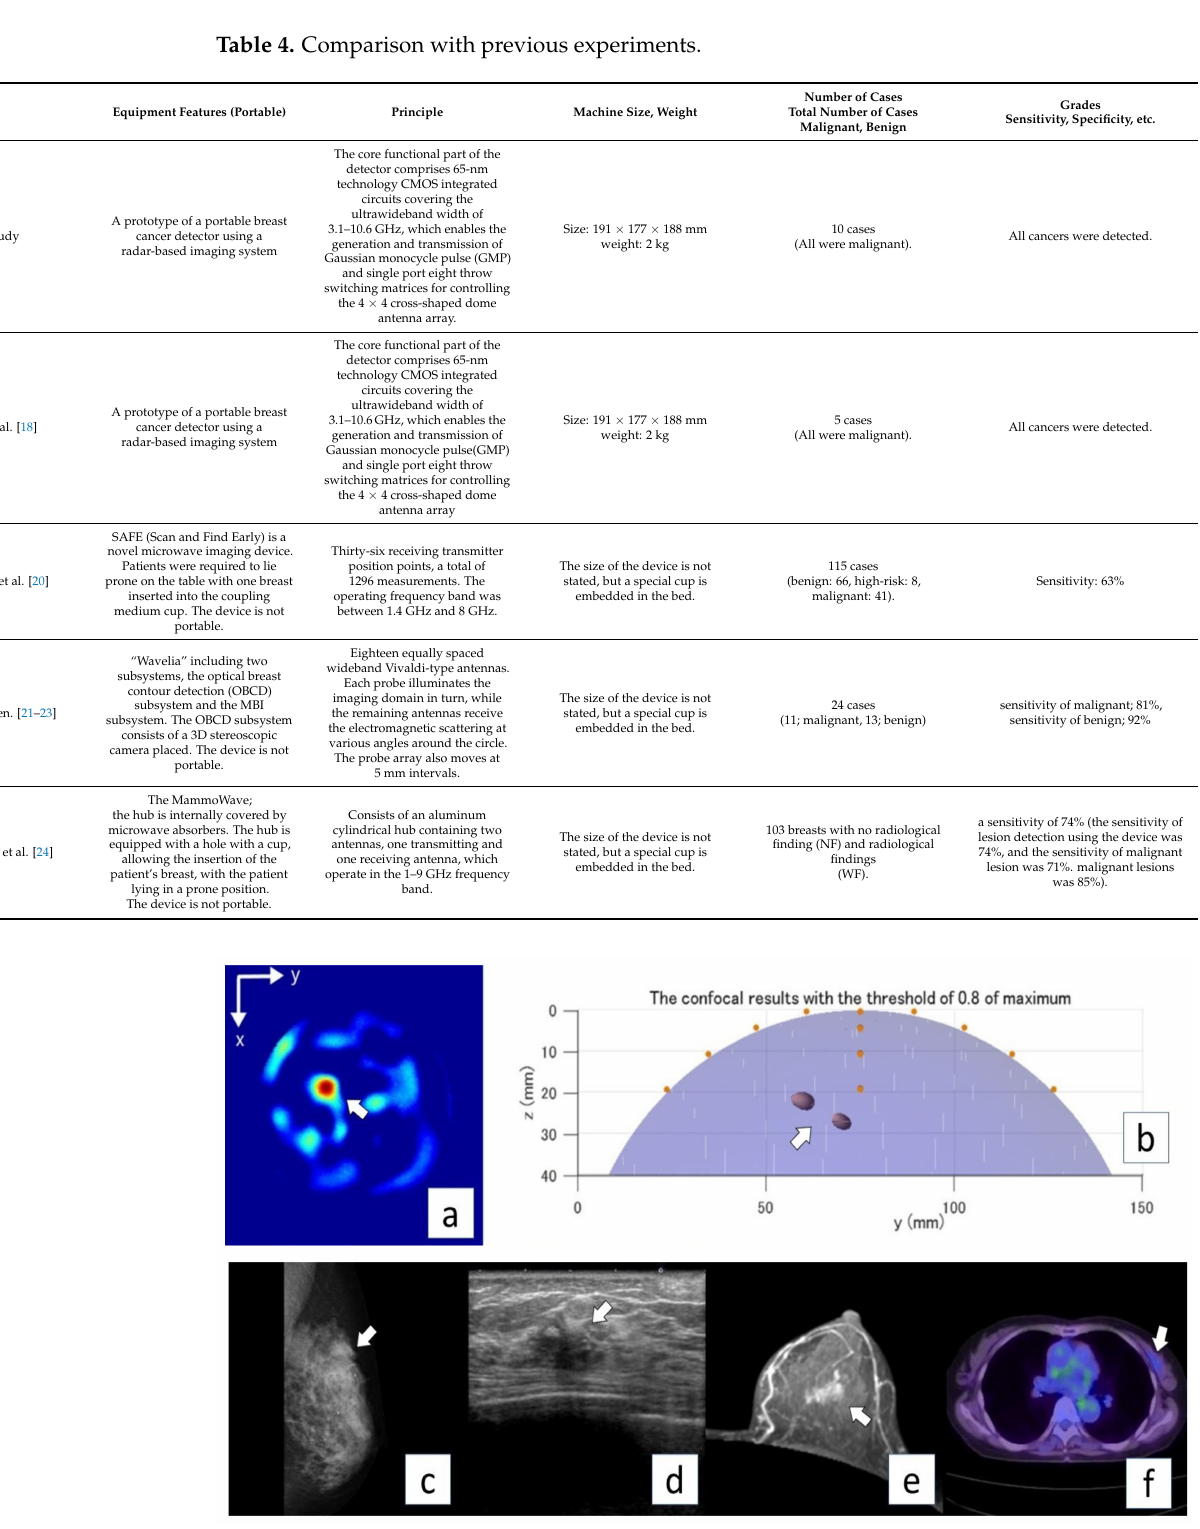
Figure 5. Representative case (Case 6). A 73-year-old woman with invasive ductal carcinoma (invasive lesion, 14.0 mm; total lesion, 40 mm) in the left breast. MG mediolateral oblique view ( a ) shows a focal symmetric density in the upper aspect of the lesion (arrow). US ( b ) and MRI (axial plane, contrast MRI) ( c ) show an irregular mass in the left breast (arrows). PET/CT ( d ) shows mild FDG uptake in the left breast (arrow). Microwave imaging 2D-coronal view ( e ) and 3D-axial view ( f ) also show the breast cancer lesion in the left